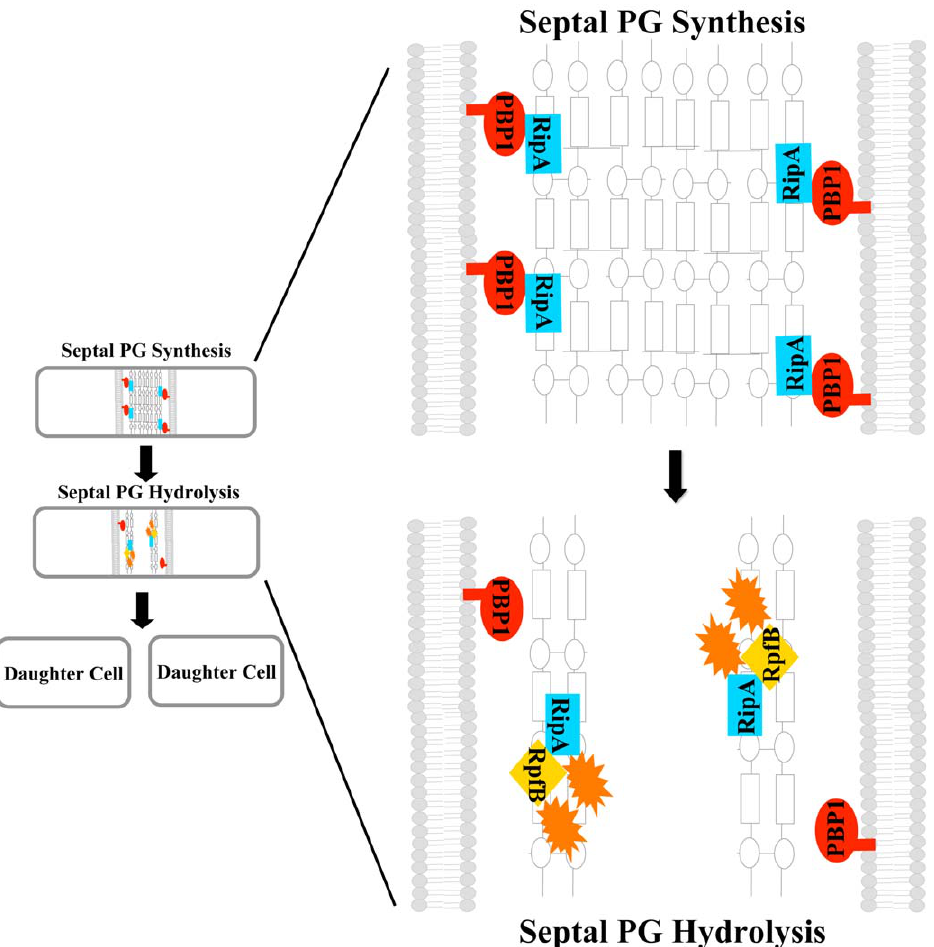
Figure 8. Model of RipA regulation by PBP1 during septation. A RipA-PBP1 complex that exists at the initiation of septation may synthesize a thick layer of peptidoglycan (PG) between daughter cells during the process of cytokinesis. After PG synthesis and fission are finished, RipA may exchange PBP1 for autolysin binding partners like RpfB. These new complexes are highly efficient at PG hydrolysis and will separate the cell walls of the two mature daughter